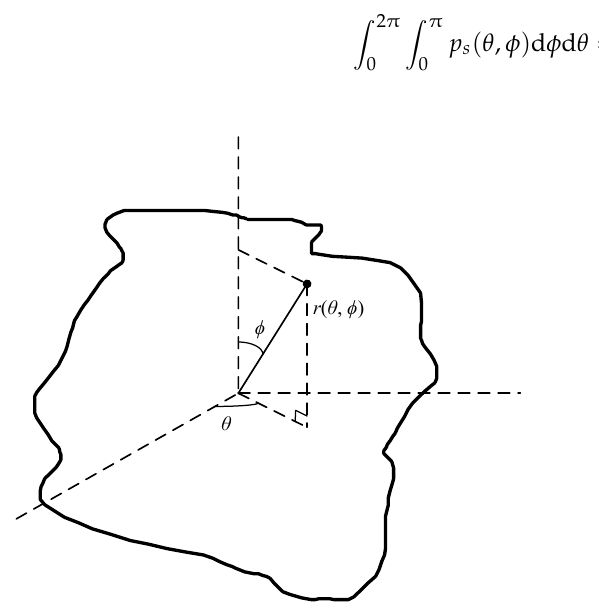
Figure 5. An illustration of arbitrary spatial geometry.